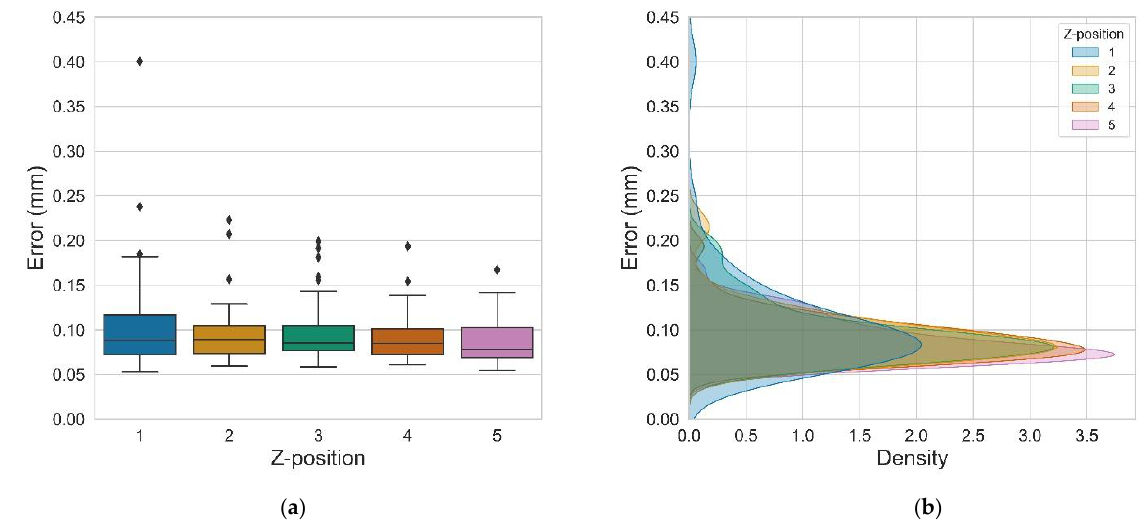
Figure 22. Comparison of flatness error at different z-positions in the build chamber. ( a ) Boxplot of all five z-levels; ( b ) kernel density estimations for the levels of z-positions. Table 10. Statistical description of measured flatness error of planes 2 and 5 from HX2 and the difference between the five z-levels.